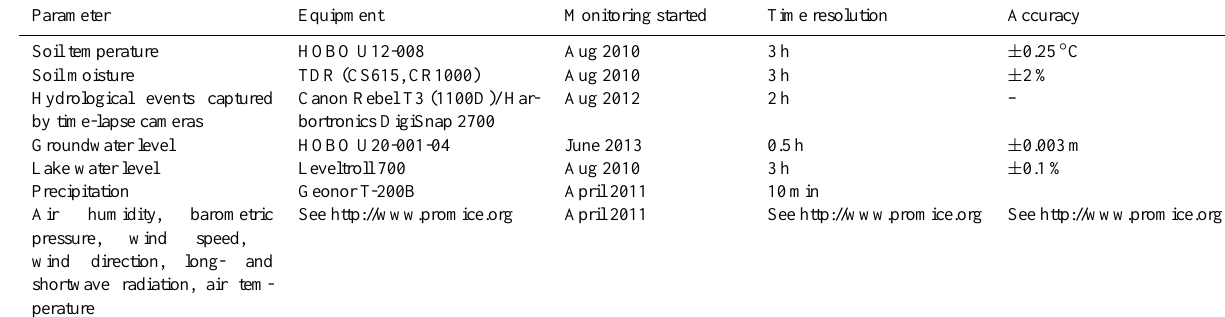
Table 1. (a) List of equipment used, start of monitoring, time resolution, and accuracy for each parameter for all monitoring data.